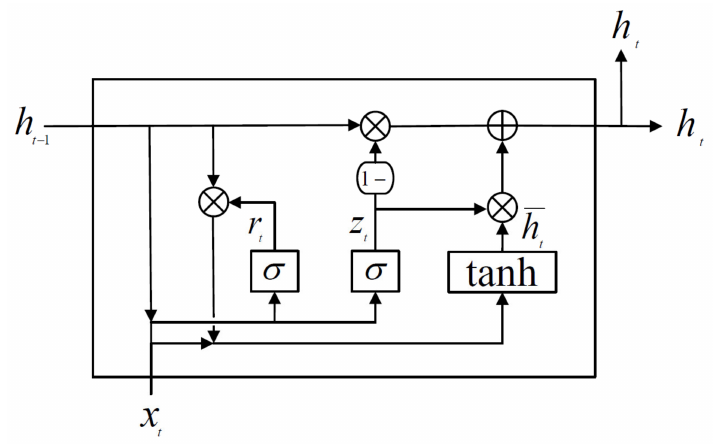
Figure 5. Gated Recurrent Unit